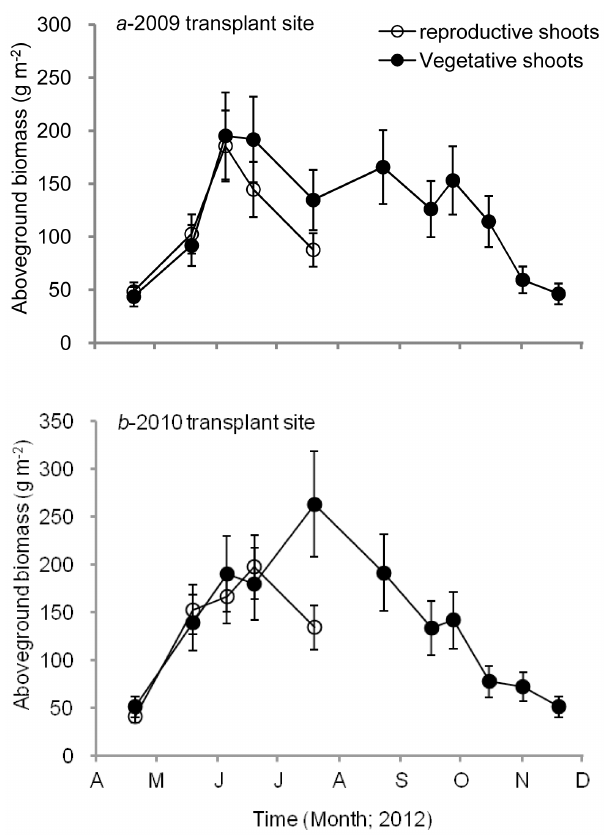
Figure 4. Variations in aboveground biomass of Zosteramarina N (g DWm 2 2 ) at the 2009 ( a ) and 2010 ( b ) transplant sites. # , , vegetative shoots. Values are means 6 SD. reproductive shoots;